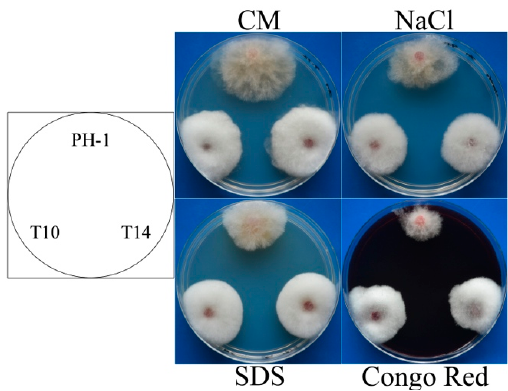
Figure 4. Assays for vegetative growth of the Δ gil1 mutants in the presence of different stresses. Cultures of the wild-type (PH-1) and the Δ gil1 mutants (T10 and T14) grown on regular CM, CM with 0.7 M NaCl, 0.01% SDS, or 300 µg/mL Congo Red. Photographs were taken after incubation at 25 °C for three days.